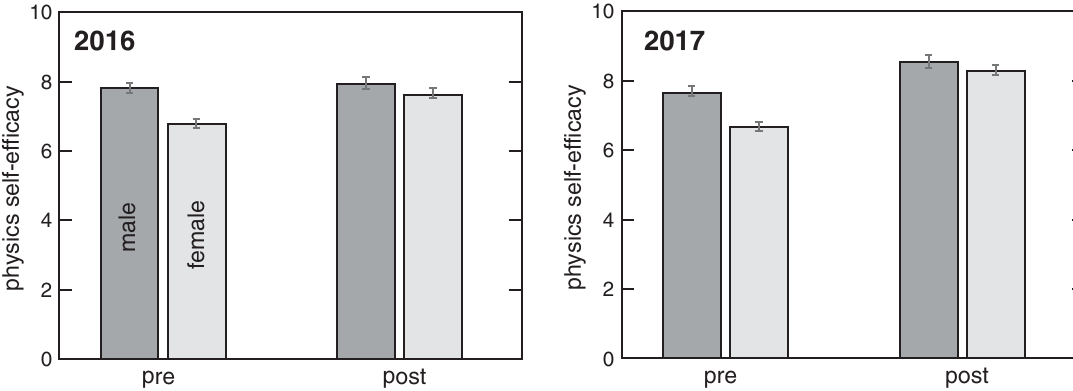
FIG. 1. Physics self-efficacy scores obtained using the PSES survey in Appendix at the beginning (pre) and end (post) of the semester. Dark gray: male students; Light gray: female students. N ¼ 65 for 2016 and N ¼ 39